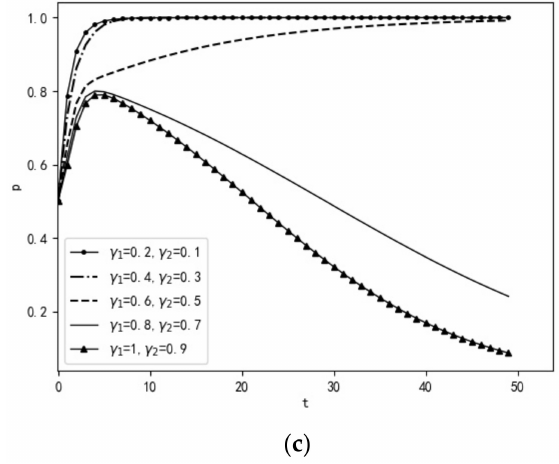
Figure 6. The effect of supervisor self-healing probability on tripartite strategy evolution. ( a ) The impact of supervisor self-healing probability on the local government. ( b ) The impact of supervisors self-healing probability on enterprises. ( c ) The effect of supervisor self-healing probability on the